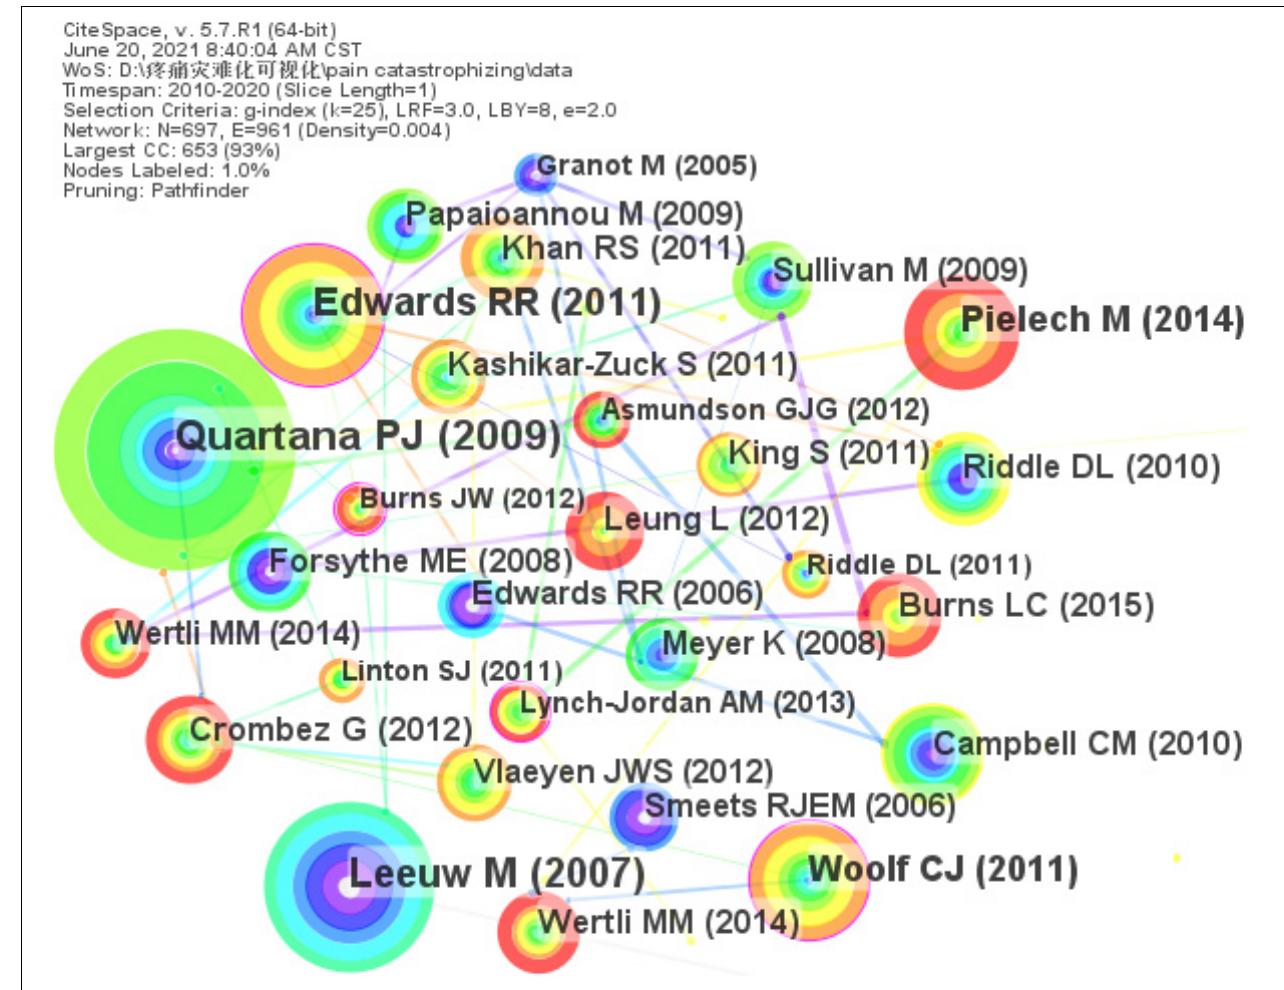
FIGURE 5 | Reference co-citation map related to pain catastrophizing research from 2010 to